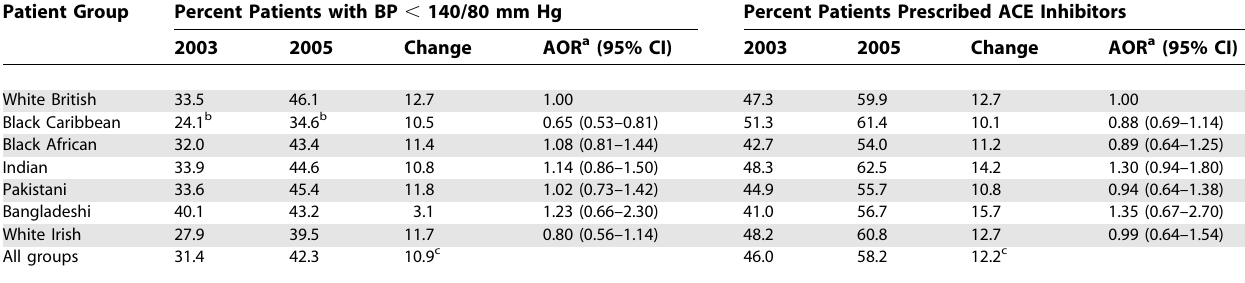
Table 3. Ethnic Disparities in BP Management and Control Patient Group Percent Patients with BP , 140/80 mm